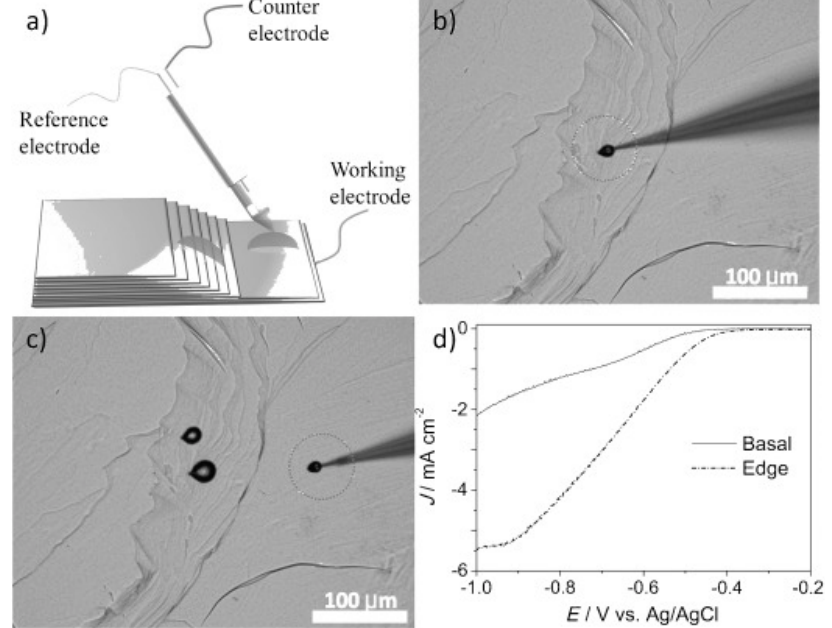
Figure 2. ( a ) Schematic illustration of the micro appliance for the oxygen reduction reaction (ORR) activity analysis. Optical image for showing the highly oriented pyrolytic graphite (HOPG) substrate serving as a working electrode by placing an air-saturated electrolyte droplet on ( b ) the edge and ( c ) the basal plane of HOPG. ( d ) LSV curves for ORR proceeded in an air-saturated electrolyte deposited either on the edge (see panel b ) or on the basal plane (see panel c ) of HOPG. (Reprinted with permission from Ref. [23], 2014 WILEY-VCH).